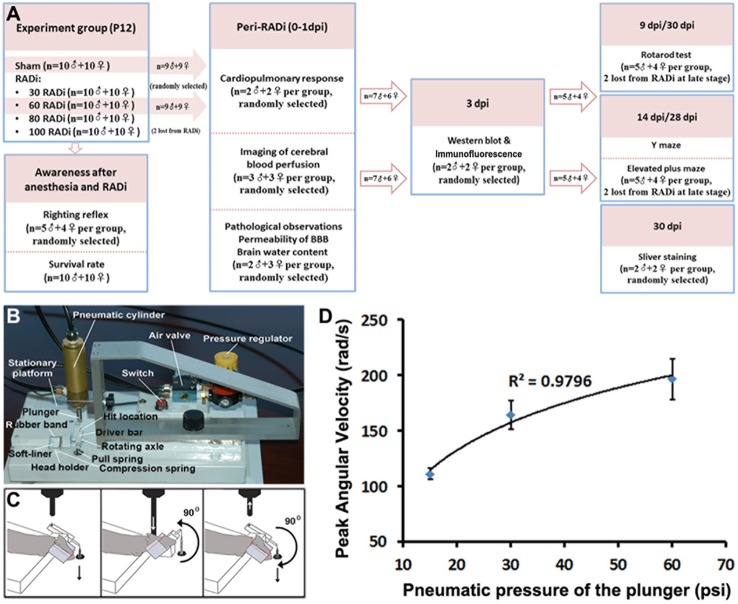
Study design and RAD brain injury model. (A) Experimental workflow for rotational acceleration-deceleration TBI in developing mice. (B) Illustration of the major components of the RADi device. (C) Schematic of the RADi procedure. Hyperextension of the neck occurs when the plunger strikes the ‘driver bar’ at the ‘hit location’ site (white down arrow) on activation of the pneumatic cylinder. When the plunger is released (white up arrow), the neck is forced back to the flexed position by the compression spring attached to the anterior part of the rotating axle (black down arrow). Each hyperextension-flexion cycle represents one rotation. (D) Pneumatic pressure of the plunger (psi) versus the peak angular velocities (rad/s) of the head.